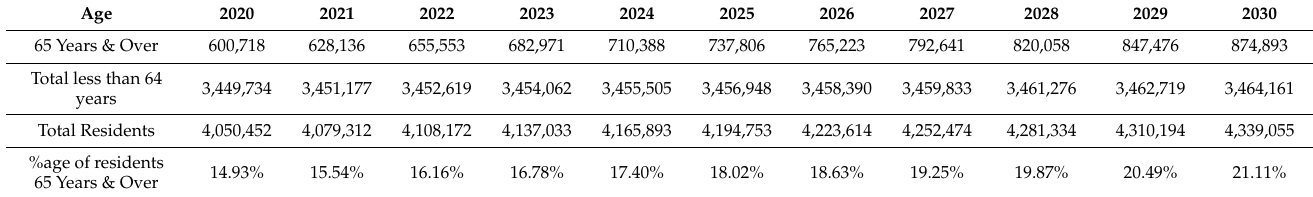
Table 5. Projection of Age Group (65 Years and Over versus less than 64